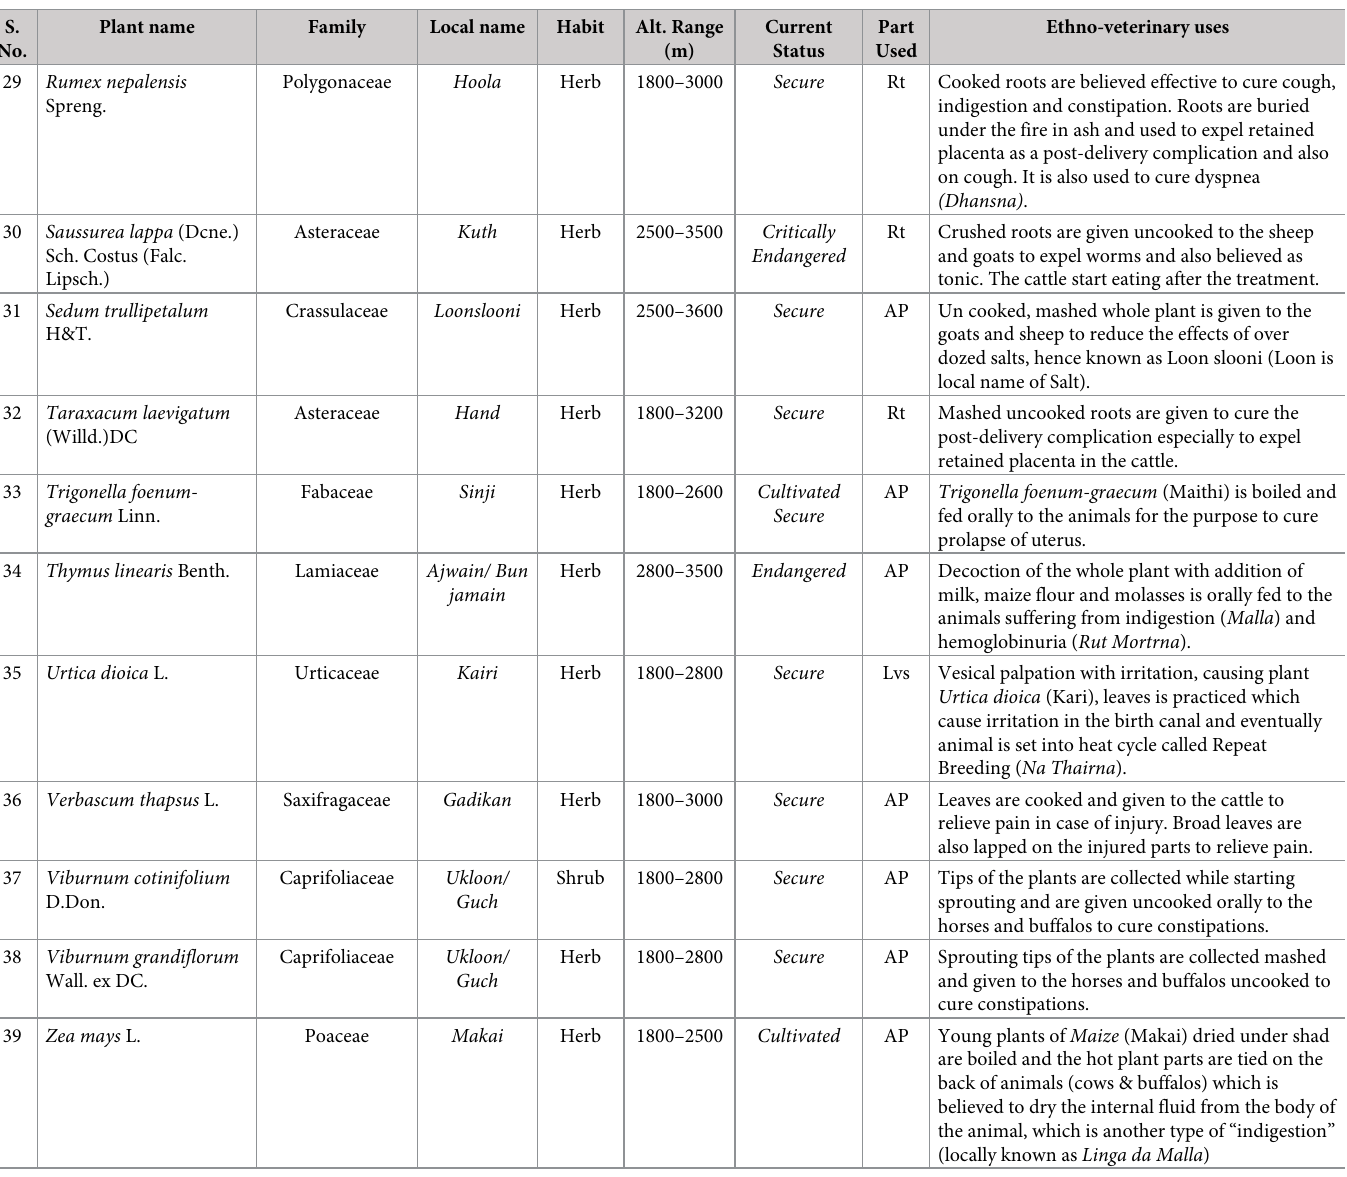
were represented by one species each (Fig 2: Family-wise distribution of the plants used for veterinary